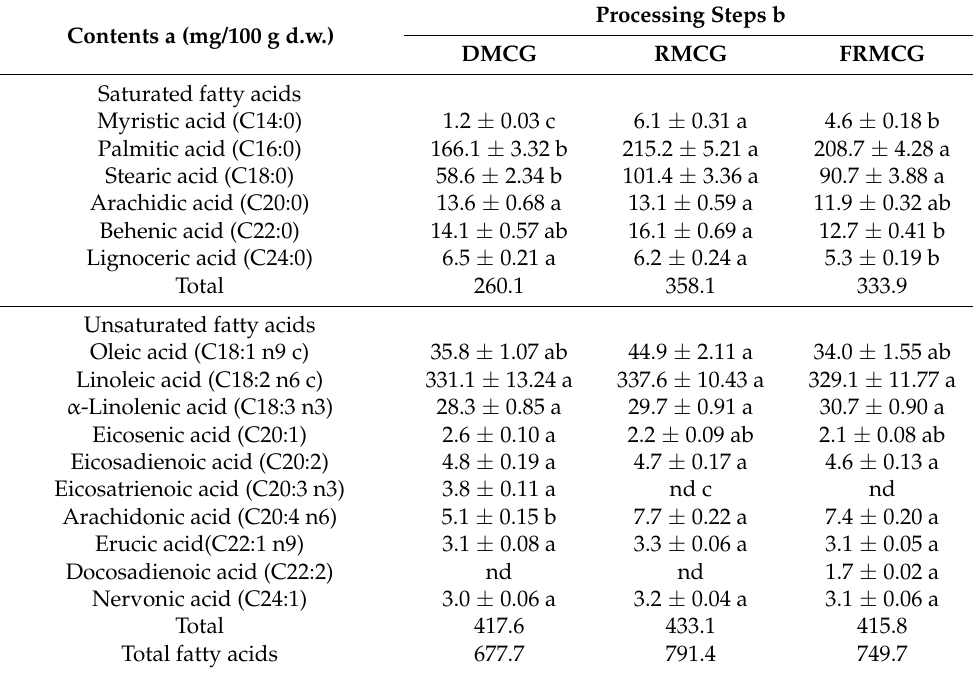
Table 1. Change of the fatty acid contents during food processing steps of mountain-cultivated ginseng with the cocktail lactic acid bacteria. Contents a (mg/100 g